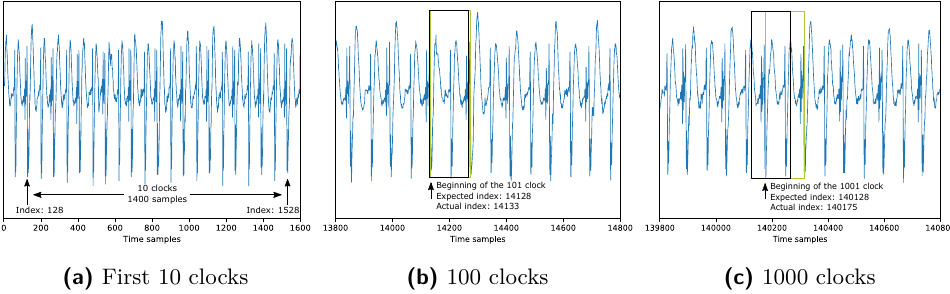
Figure 3: Increasing deviation between the beginnings of filters and clock